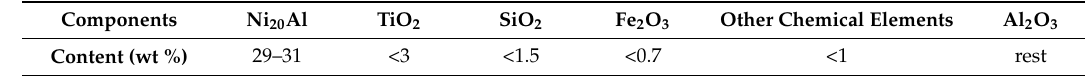
Table 2. Chemical composition of the METCO